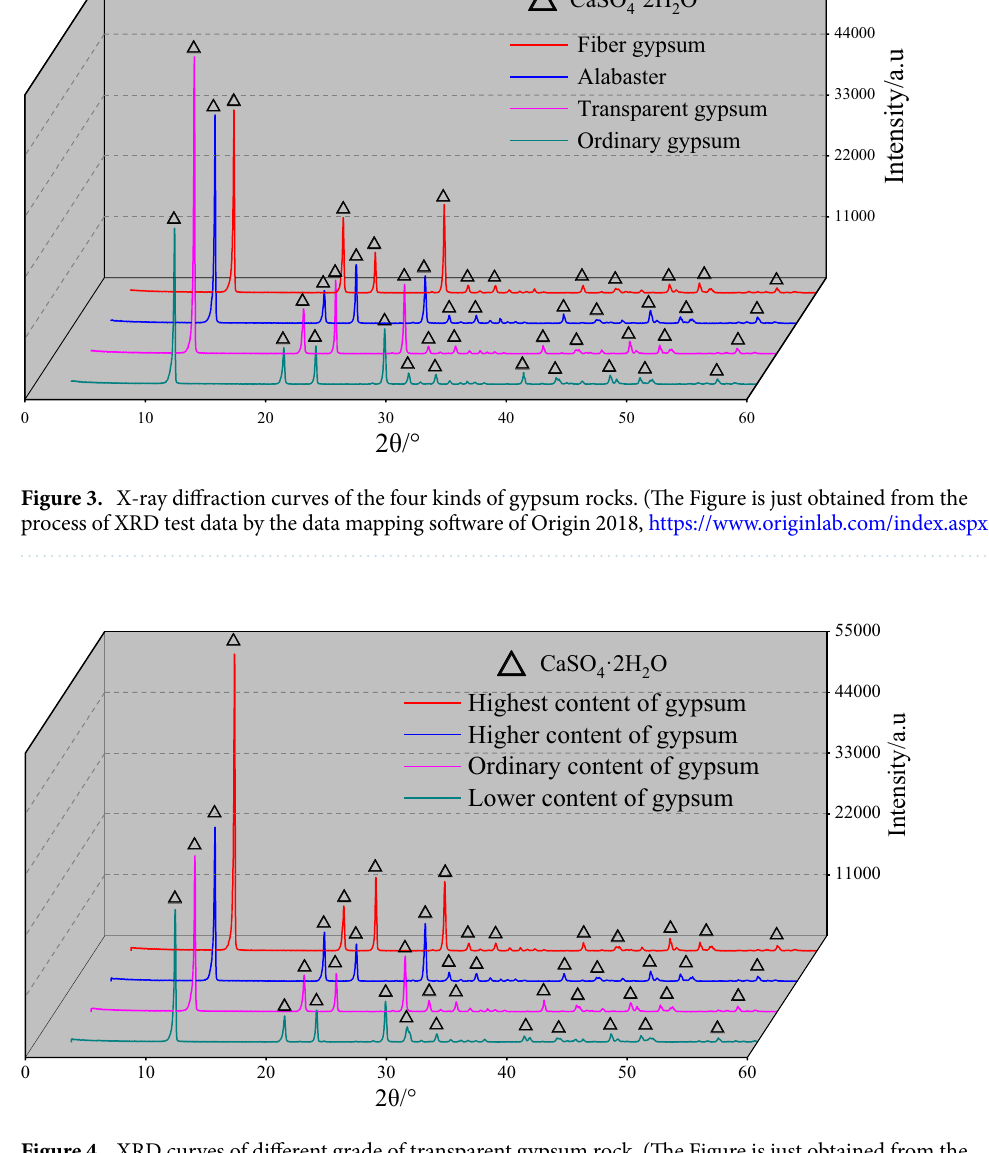
Figure 4. XRD curves of different grade of transparent gypsum rock. (The Figure is just obtained from the process of XRD test data by the data mapping software of Origin 2018, https:// www. origi nlab. com/ index. aspx, and the generation process of the figure is consistent with Figs. 5 and